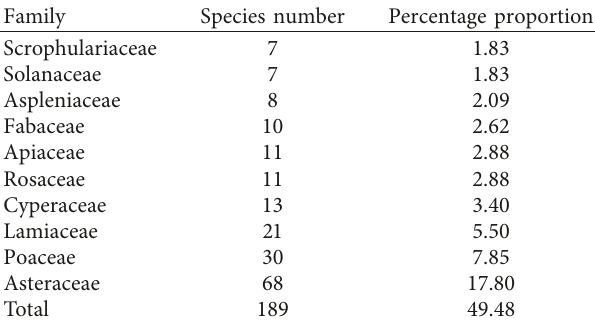
Table 3: Top 10 species richest families of the study vegetation with increasing order of